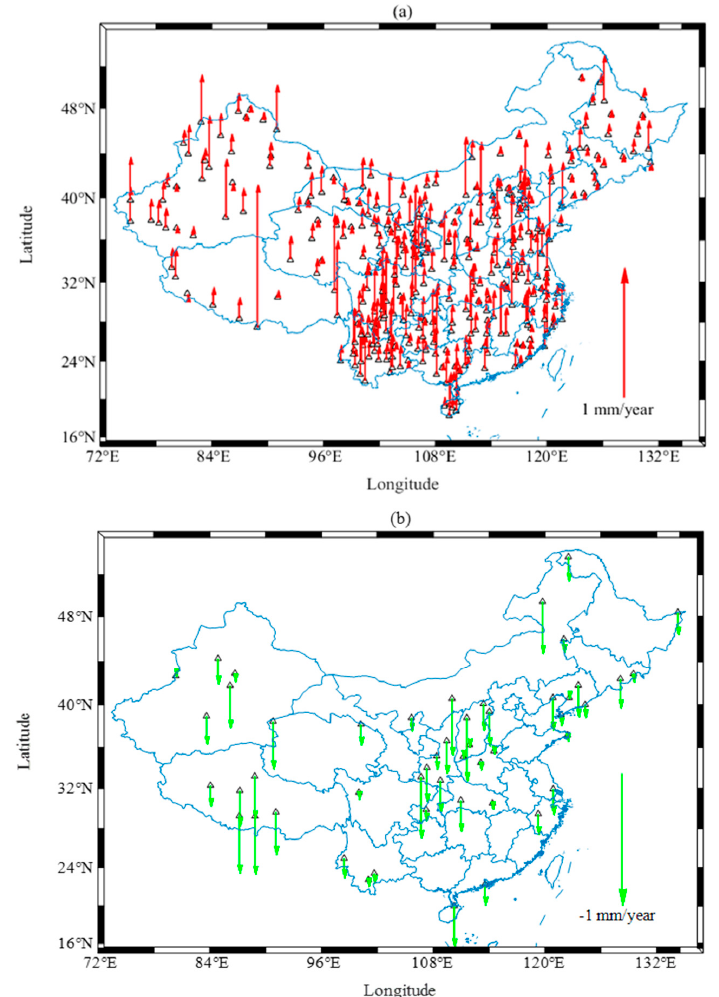
Figure 12. Long-term variation trend of the PWV. The red upward arrows ( a ) stand for the increase of the PWV variation trend (mm/year), and the green downward arrows ( b ) represent the decrease of the PWV variation trend (mm/year).